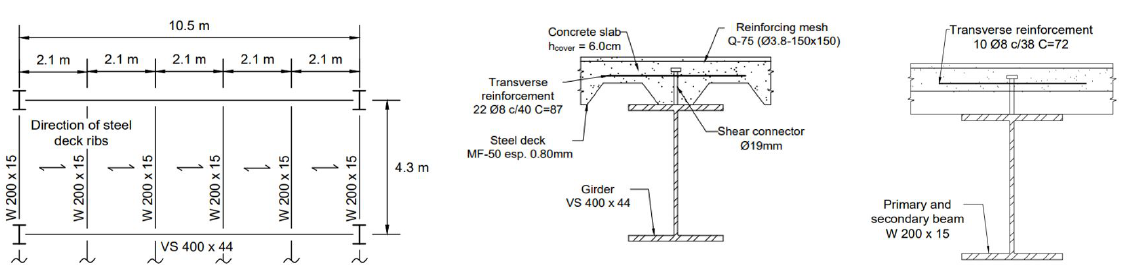
Figure 9. Optimal floor geometry for example